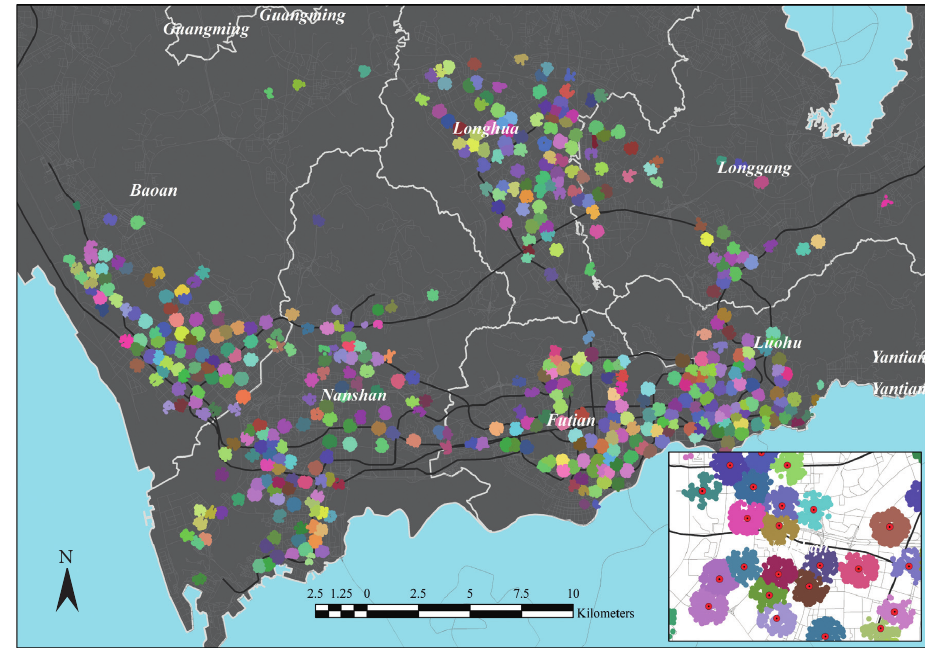
Figure 3: The OFO bicycle gathering area identified by mean shift clustering.